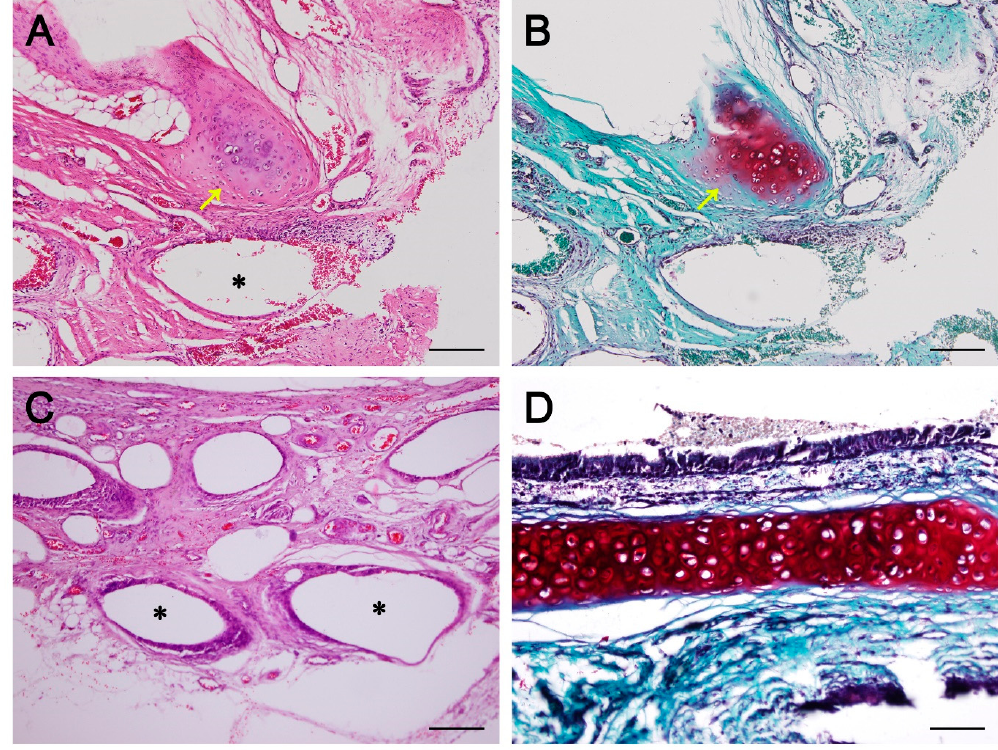
Figure 7. Neo-cartilage formation and neo-vascularization. Neo-vascularization and neo-cartilage formation was observed in the d-MSC group ( A , B ). However, in the MSC group, neo-vascularization was seen but no cartilaginous islet was observed ( C ). Newly formed immature cartilage islet (yellow arrows) had higher cellular density and lighter proteoglycan staining compared with the cartilage of the normal trachea ( D ). A, C and D = hematoxylin and eosin staining; B = safranin O staining. Asterisks (*) indicate fifth polycaprolactone (PCL) layer and all scale bars indicates 50 µm).